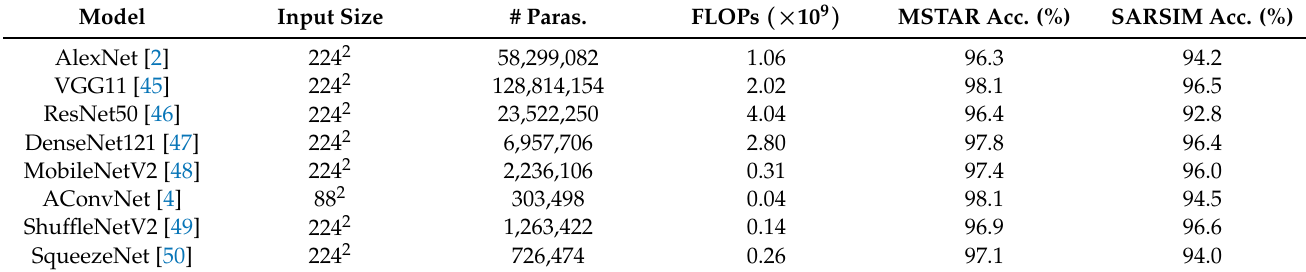
Table 3. Details of the studied